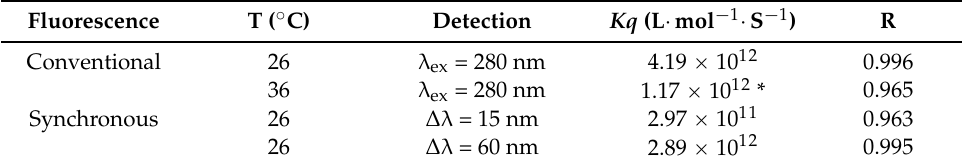
Table 1. Quenching reactive constants of HSA by SSC.